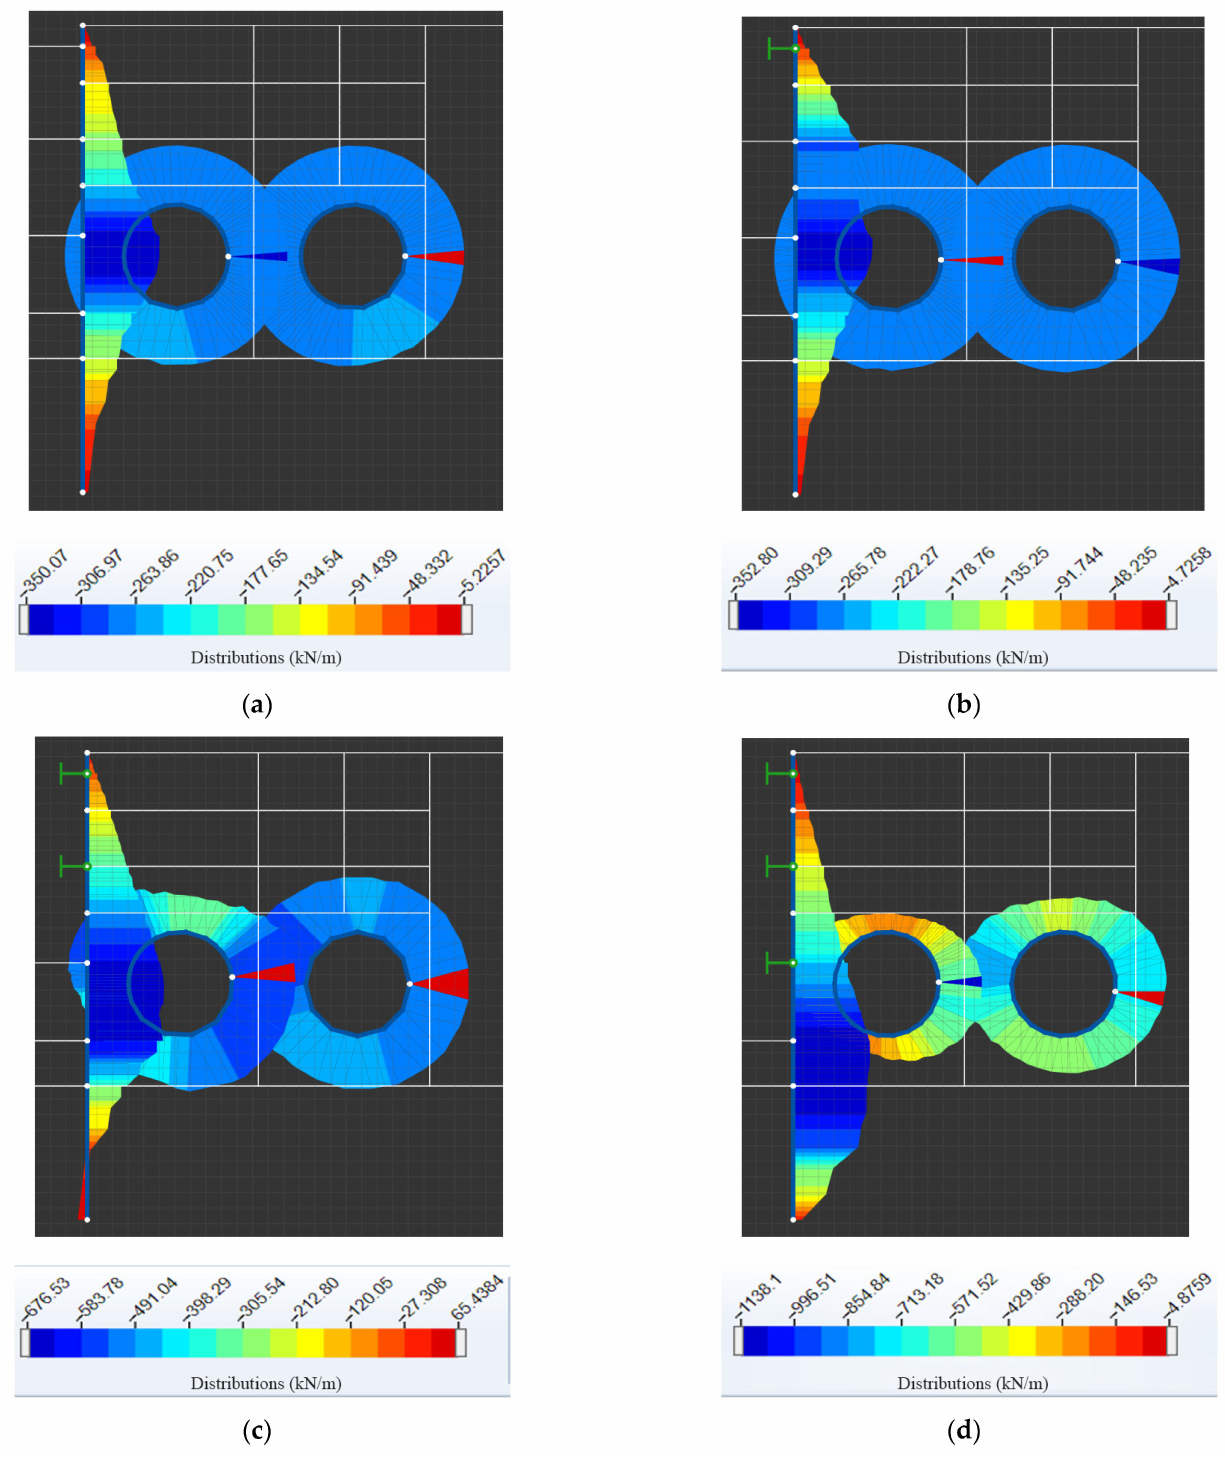
Figure 11. Axial force diagram under each stage: ( a ) Stage (1) ( h = 0.08 H), ( b ) Stage (2) ( h = 0.4 H), ( c ) Stage (3) ( h = 0.75 H) and ( d ) Stage (4) ( h = 1.0 H). Influence of Horizontal Distance L on Global Stability Influence of the horizontal distance L between twin tunnels and foundation pit on global stability is analyzed in this section. In the following paragraphs, the influence of horizontal distance L on safety factor of global stability and global failure mechanism under four stages of the foundation pit construction are investigated,